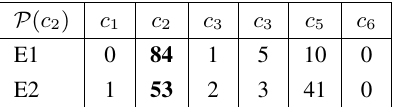
Table 8. Predictions for all 100 crop type 2 samples from 2018 (correct predictions in bold